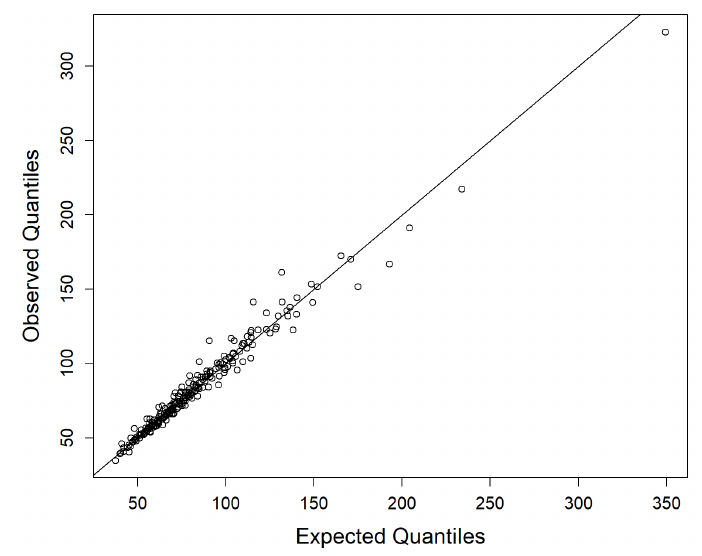
Figure 4. Quantile–quantile plot of PM2.5 maxima in the Mexico City metropolitan area.